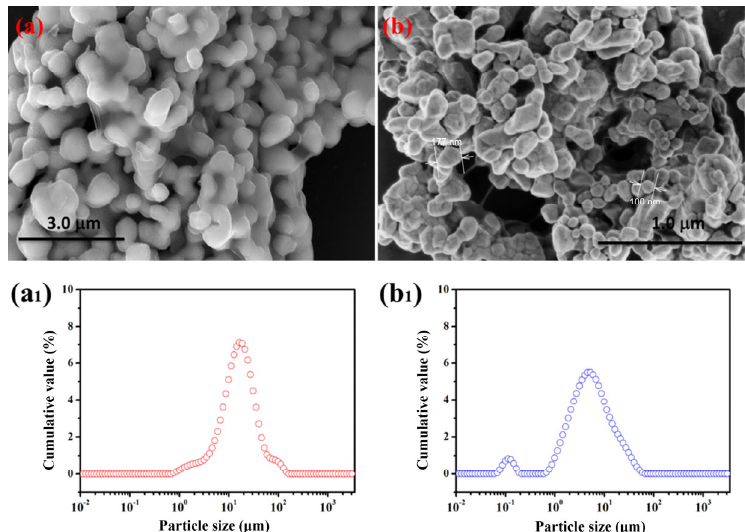
Fig. 1 SEM morphologies and particles size distribution of ((a) and (a1)) molybdenum and ((b) and (b1)) silver.